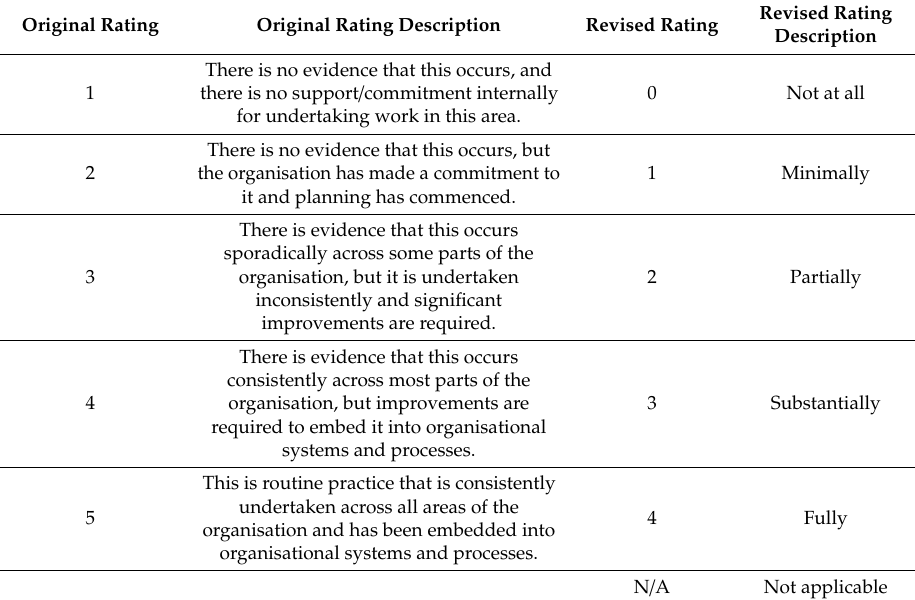
Table 7. Rating scale and descriptions of the original and revised Org-HLR